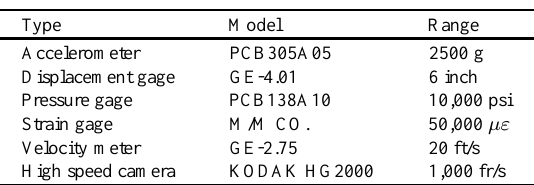
Fig. 1. Schematic diagram of test instrumentation. Table 1 Characteristics of